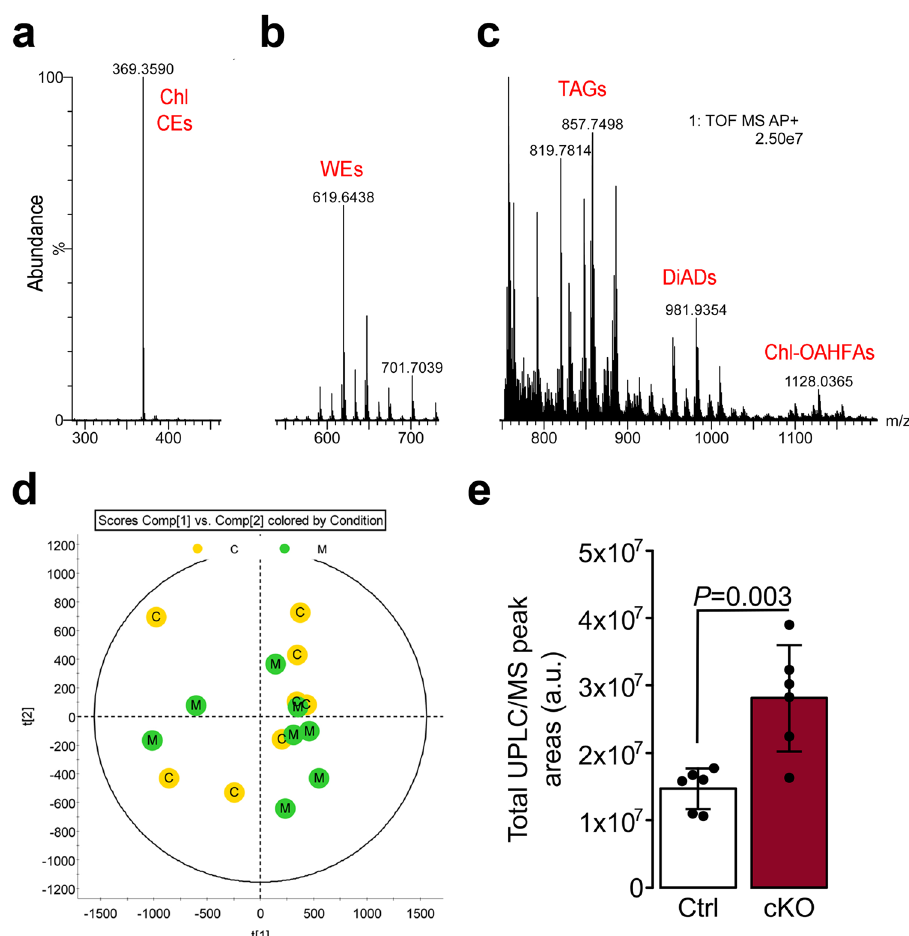
Fig. 2 Reverse phase liquid chromatography/high-resolution time of fl ight atmospheric pressure chemical ionization mass spectrometry (LC/MS) analysis of mouse meibomian lipids conducted in the positive ion mode revealed close similarity in the lipidomes of control and cKO mice, but a two- fold increase in the total lipid content of the latter. a An analytical signal of free cholesterol (Chl) and cholesteryl esters (CEs) from a control mouse. b An observation spectrum of the pool of meibomian wax esters (WEs) from a control mouse. ( c ) An observation spectrum of the pools of triacylglycerols (TAGs), α , ω -diacylated diols (DiADs), and cholesteryl esters of (O) -acylated ω -hydroxy fatty acids (Chl-OAHFAs) from a control mouse. d A scores plot generated using Principal Component Analysis (PCA) for the control (C, yellow dots) and cKO (M, green dots) LC/MS data demonstrated a strong overlap of the control and mutant samples of meibomian lipids with no clear clustering of the samples of different types, indicating their close biochemical compositions. e However, primary cilium ablation led to a higher overall lipid production in the tarsal plates of cKO mice compared with the lipid content of control mice ( n = 6 for Ctrl and n = 6 for cKO). Data were presented as mean ± SD. Statistical signi fi cance was assessed using the Mann-Whitney